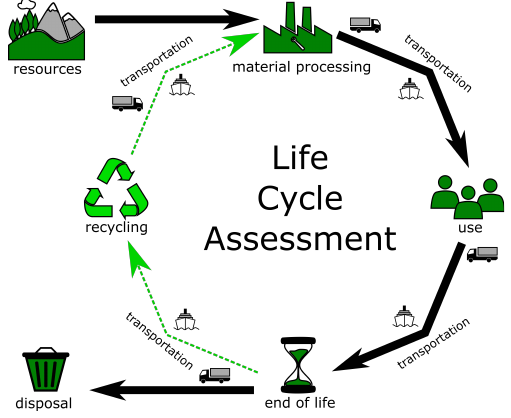
Figure 1. Simplified Life Cycle